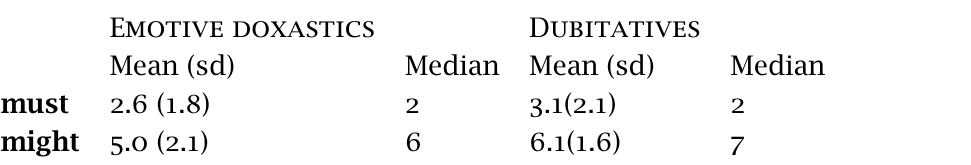
Mean/Median acceptability ratings for emotive doxastics and du- bitatives